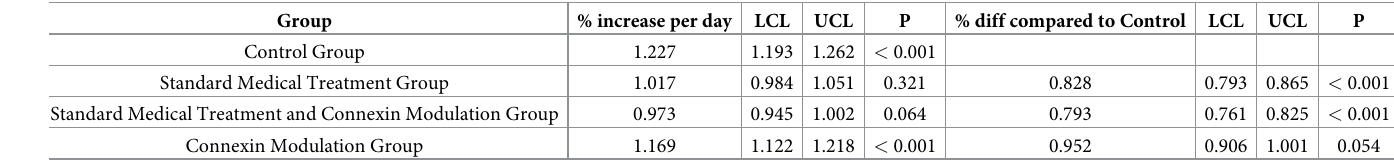
Table 3. Pairwise comparisons of the percentage tumor growth between day 3 and 13 for all treatment groups.